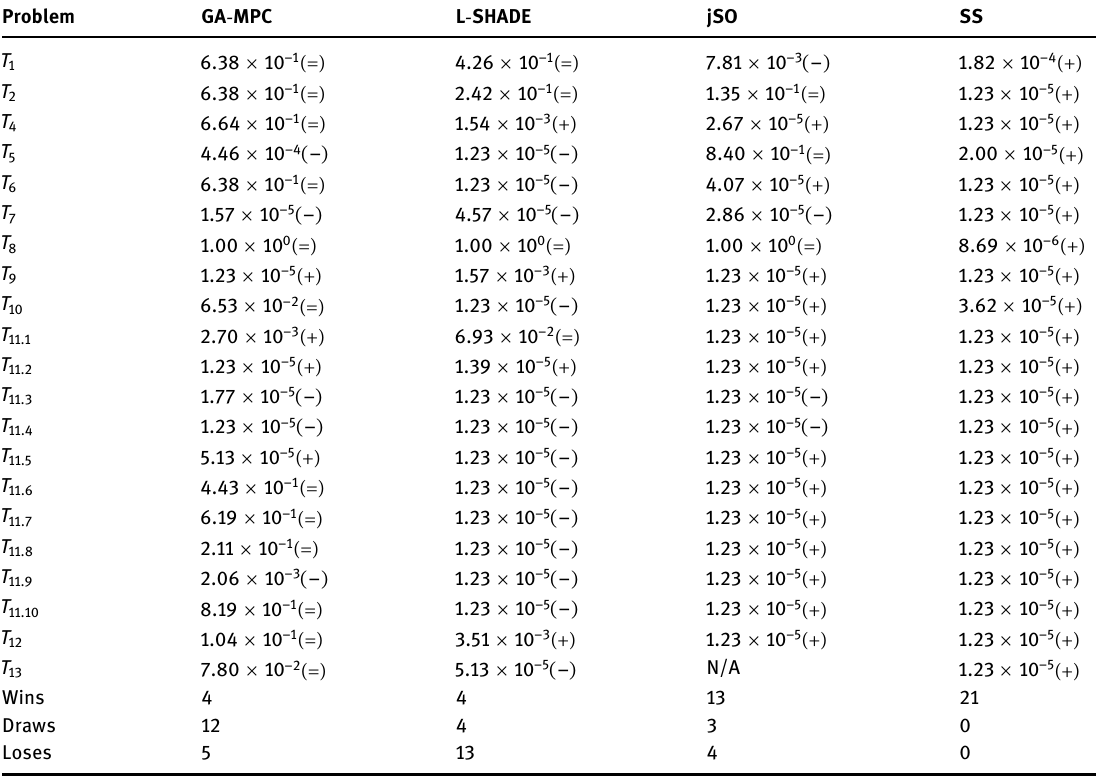
Table 17: The CEC 2011 statistical analysis showing the Wilcoxon test p - value